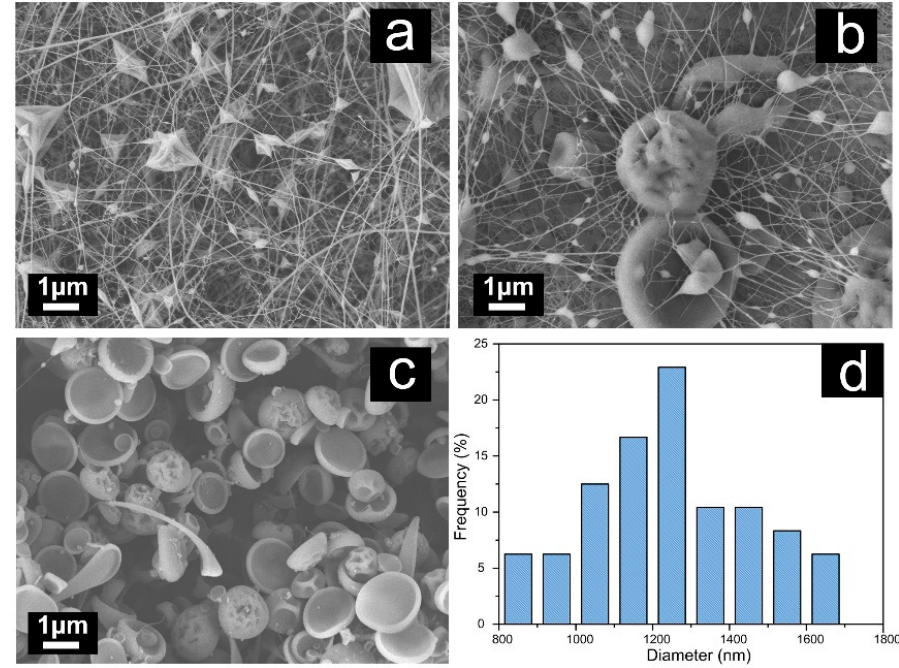
Figure 2. The morphologies of electrospinning / electrospraying CS solution with various concentrations: ( a ) 4 wt%, ( b ) 3 wt%, ( c ) 2 wt% and ( d ) hemispheres diameter distribution for 2 wt% CS.